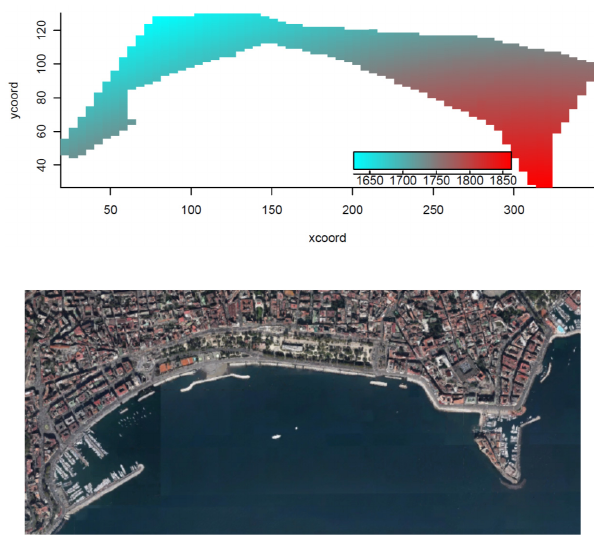
Figure 1. Spatial distribution of real estate rental values [4] compared with aerial view of urban area derived from Google Maps.